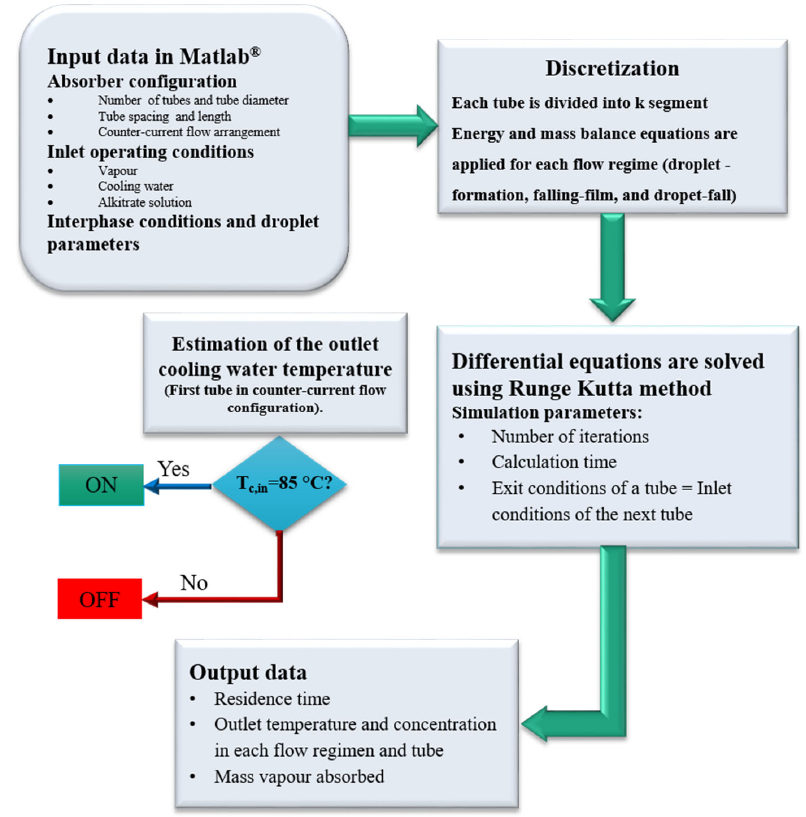
Figure 6. Calculation sequence of the model.